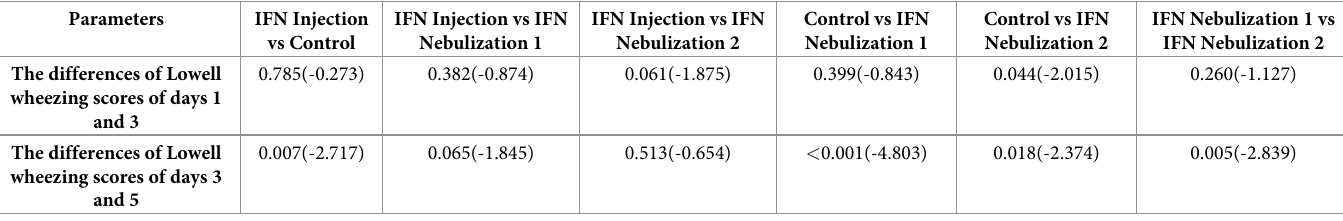
Table 9. The P values of pairwise comparisons for the differences in the Lowell wheezing scores by the Mann—Whitney U test. (Z values in the parenthesis).